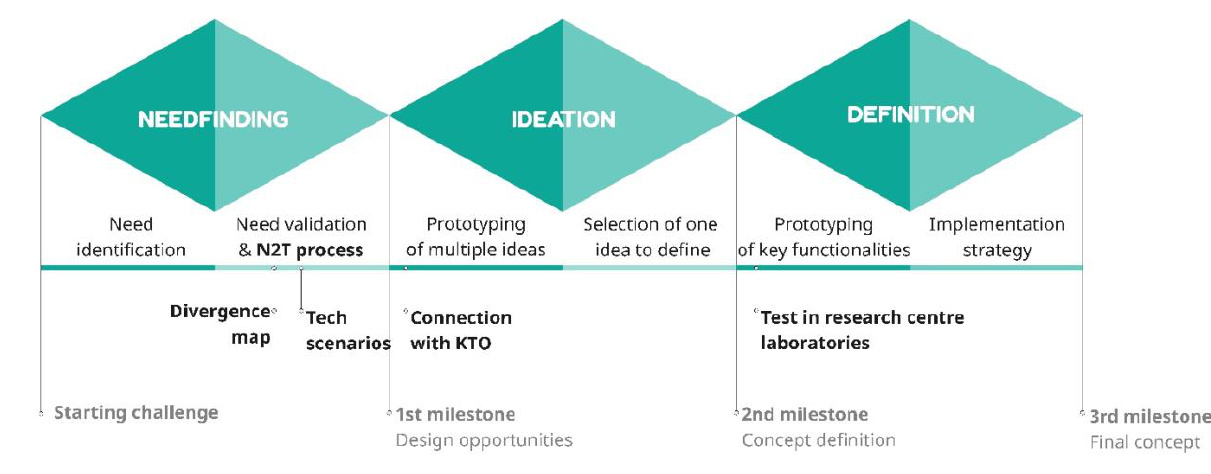
Fig. 1. Oper.CBI process and role of N2T (activities in